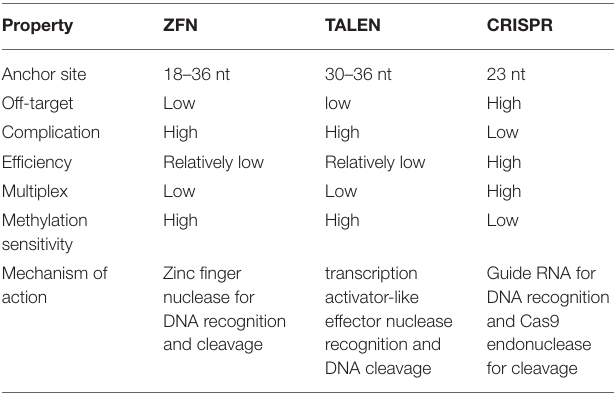
TABLE 1 | Comparison of ZFN, TALEN, and